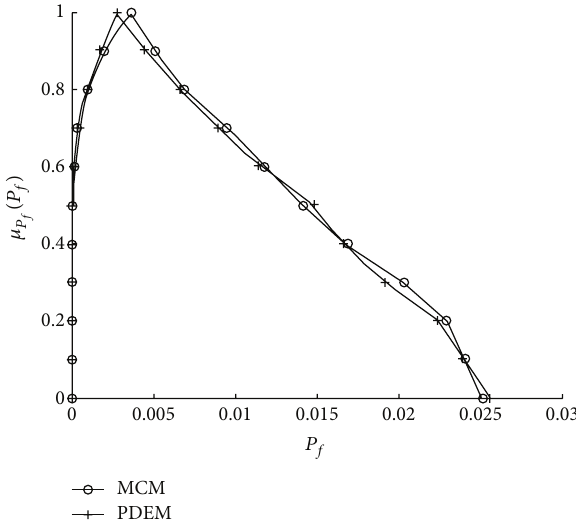
Figure 3: The membership function of 𝑃 𝑓 of Example 1.